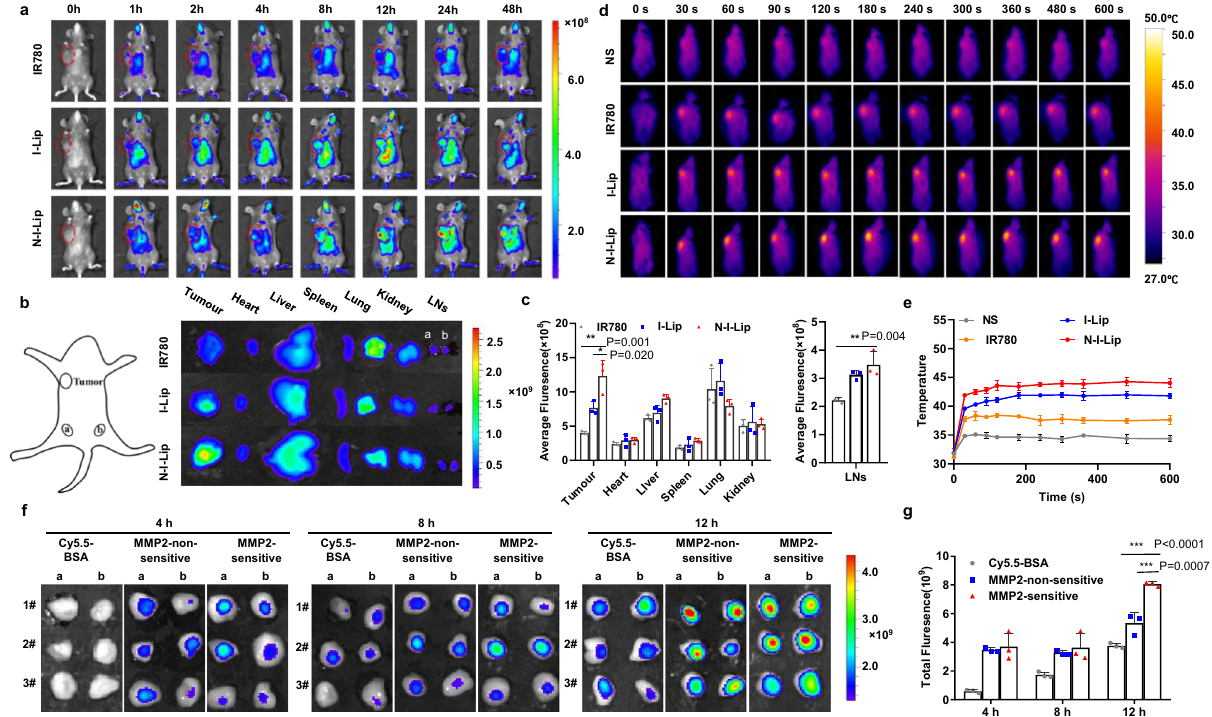
Fig. 3 | Accumulation of NIL-IM-Lip in the tumour and LNs and the local hyperthermiaeffects.a Invivo biodistribution imaging of the mice afterinjection of different formulations (i.v.). b Ex vivo imaging of the tumour, main organs and LNsat48h. c Average fl uorescenceintensitiesof the tumour,mainorgansand LNs at48h( n = 3biologicallyindependentexperiments). d Infraredthermalimagesof mice treated with NS, IR780, I-Lip and N-I-Lip under 1.0W/cm 2 laser irradiation (808nm). e Temperature pro fi les of the mouse tumours after treatment with NS, IR780, I-Lip and N-I-Lip under 1.0W/cm 2 laser irradiation (808nm) ( n = 3